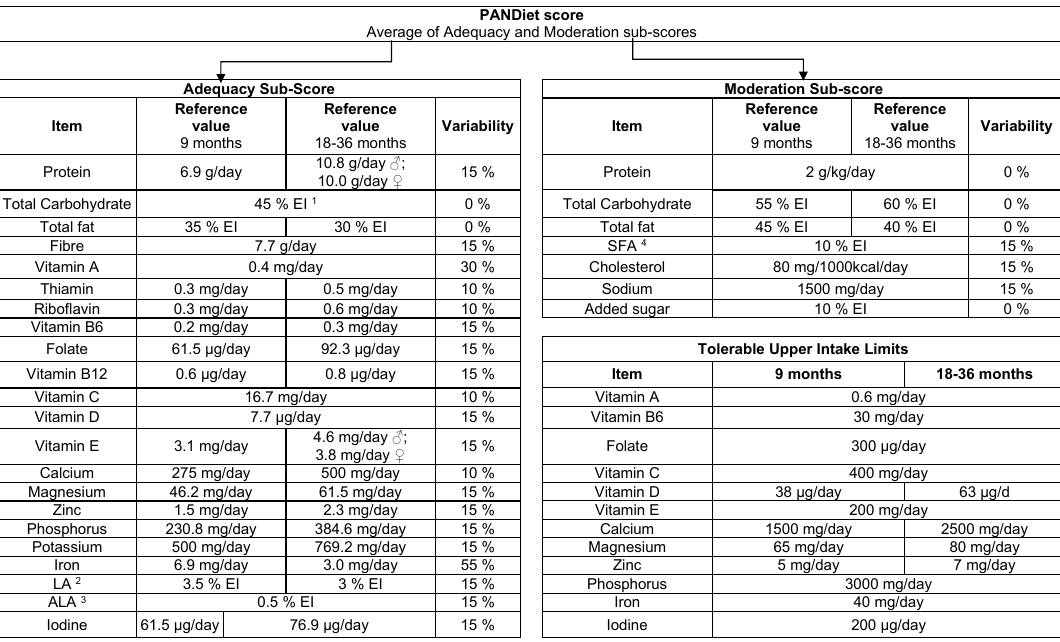
Figure A2. Determination of the PANDiet score in the BABYDIET and DONALD studies. 1 EI = Energy intake; 2 LA = Linoleic Acid; 3 ALA = Alpha Linolenic Acid; 4 SFA = Saturated Fatty Acids.